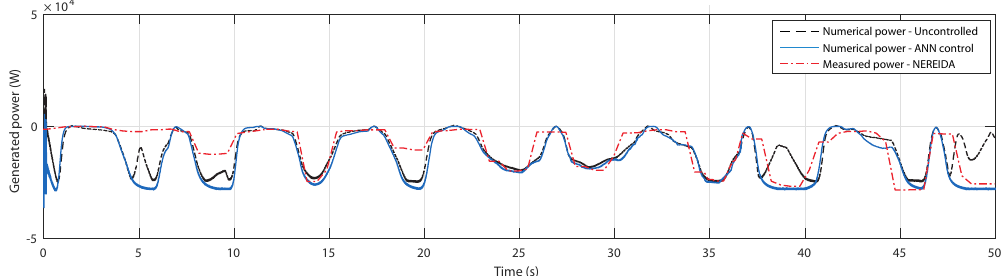
Figure 30. Produced power for uncontrolled OWC and ANN-based rotational speed controlled